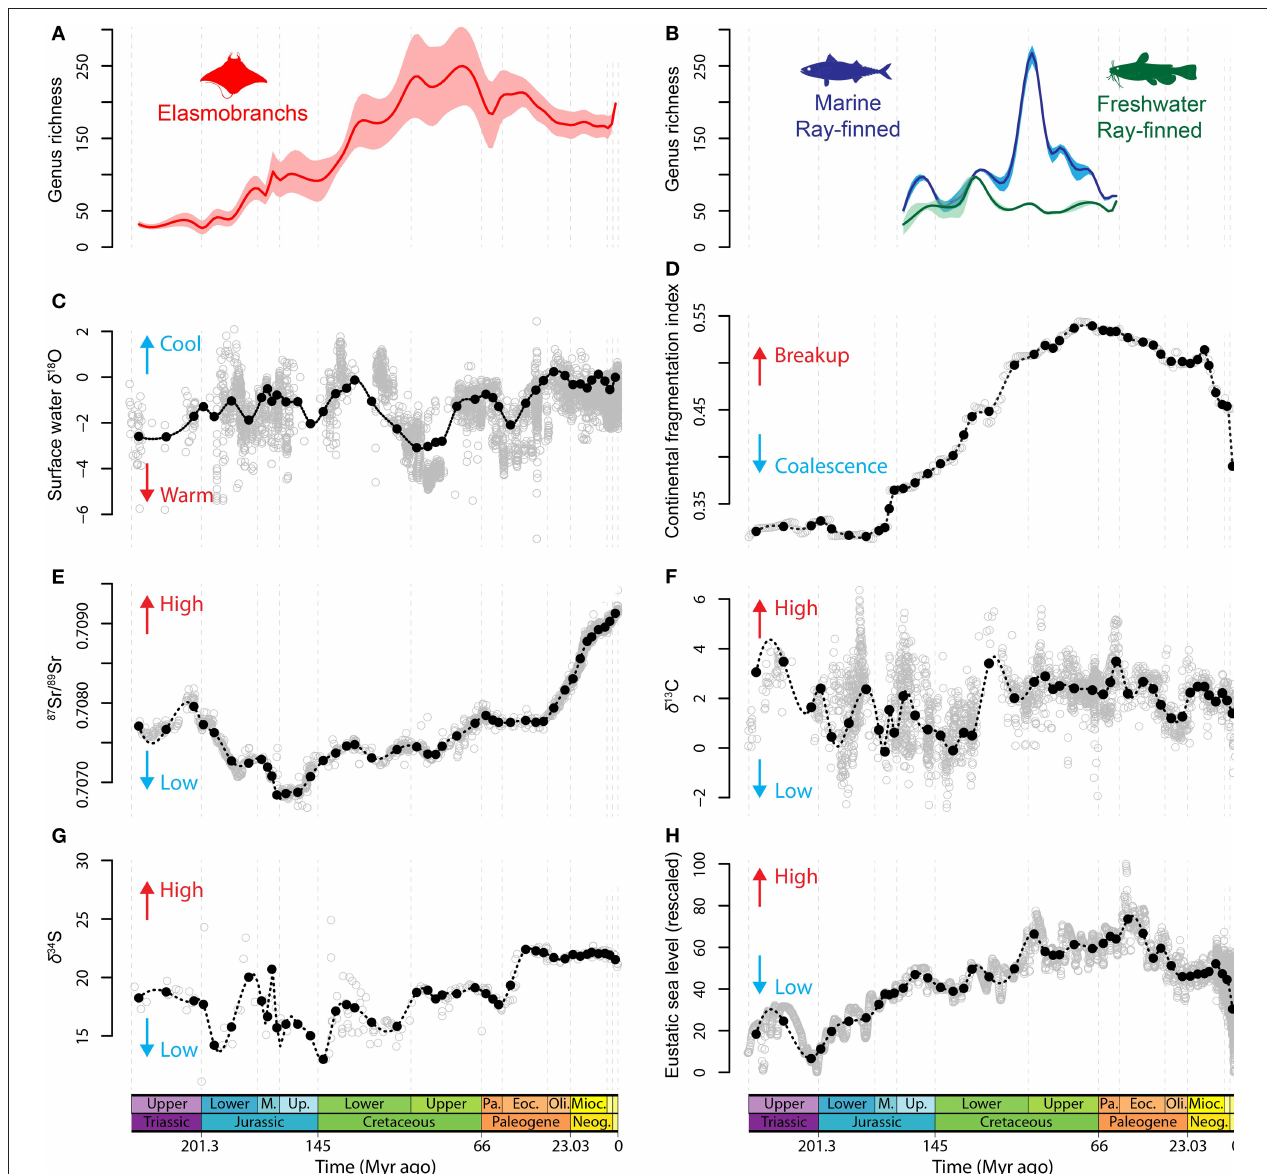
FIGURE 1 | Global “fish” genus-level diversity and abiotic variables. (A) PDE estimates for elasmobranchs and (B) for actinopterygians. Thick curves represent the median values computed to sum up the four PDE considered here and pale-colored areas represent the range of values of all PDE. Curves were produced using the spline interpolation method based on diversity values of each time bin. (C) Oxygen isotope data, (D) continental fragmentation index, (E) strontium, (F) carbon, (G) sulfur, and (H) sea-level data. Empty gray circles represent data points that served to compute mean data points (black points) for each time bin. Curves were produced using the spline interpolation method and are provided for visual representation of the trends only. Source data are available in Supplementary Data 1 .